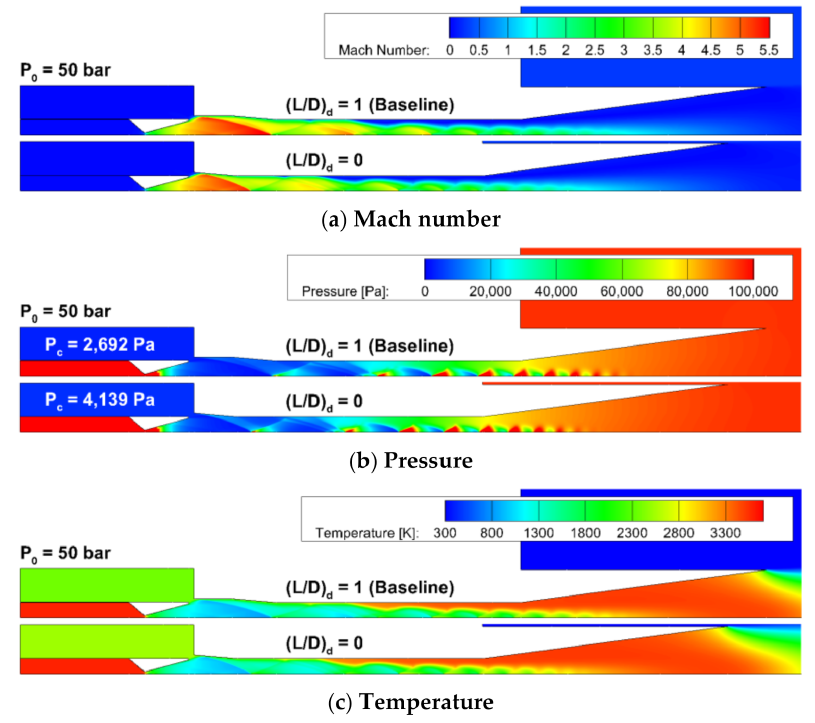
Figure 8. Comparison of two diffuser entrance length ratios.